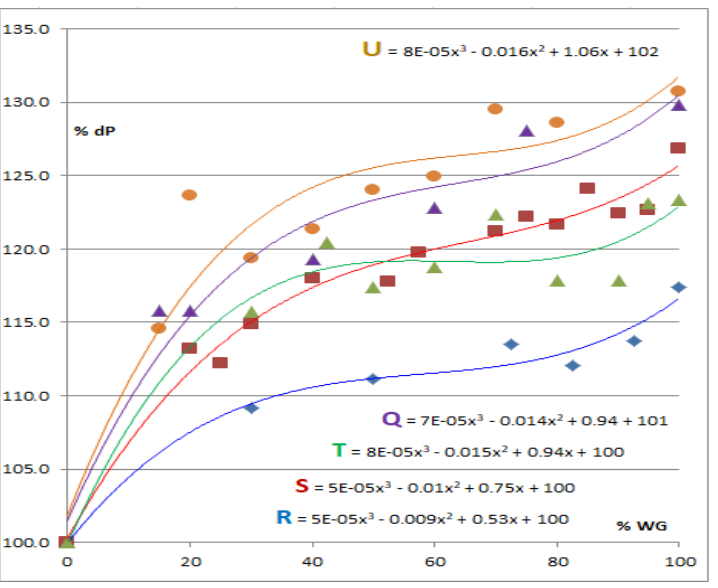
Figure 2. Maximum overpressure values in terms of wicket gate opening during load rejection procedure for medium – head Francis turbine (40 to 50 mwc) performed from 2012 to 2018 in the hydropower plants denoted Q ( ), T ( ▲ ), S ( ■ ), R ( ▲ ) and U ( ● ) [88].